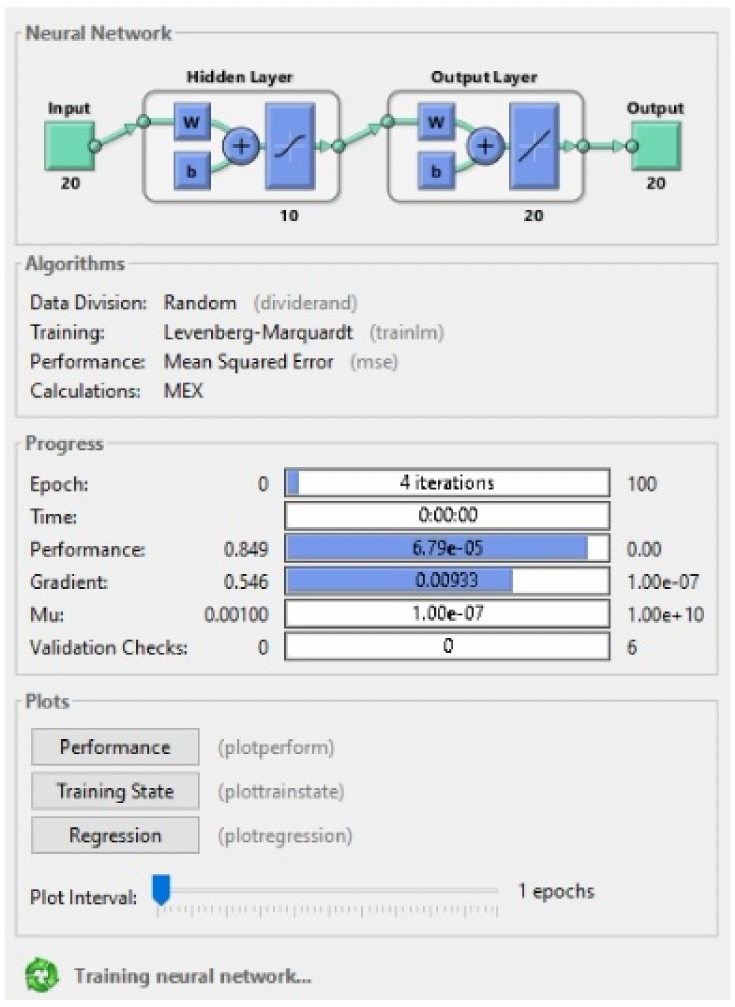
Figure 6. ANN Architecture proposed